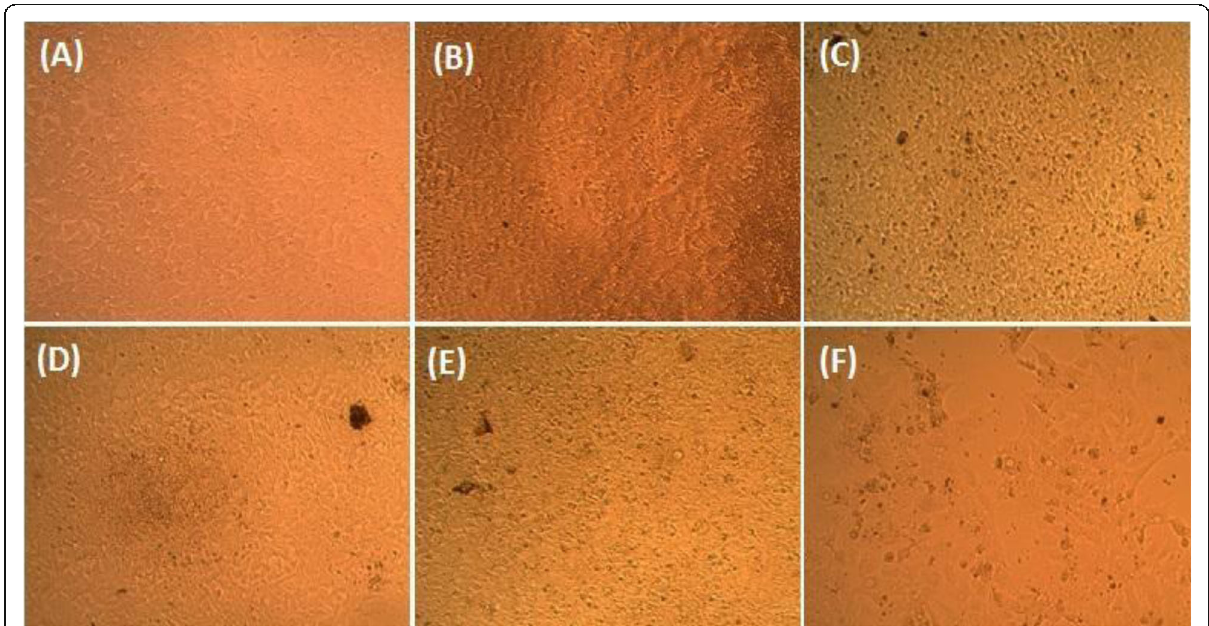
Fig. 2 PA1 cells visualized under a phase contrast microscope. A Control, treated with different concentrations of the sample (in μ g): B 6.25, C 12.5, D 25, E 50, and F